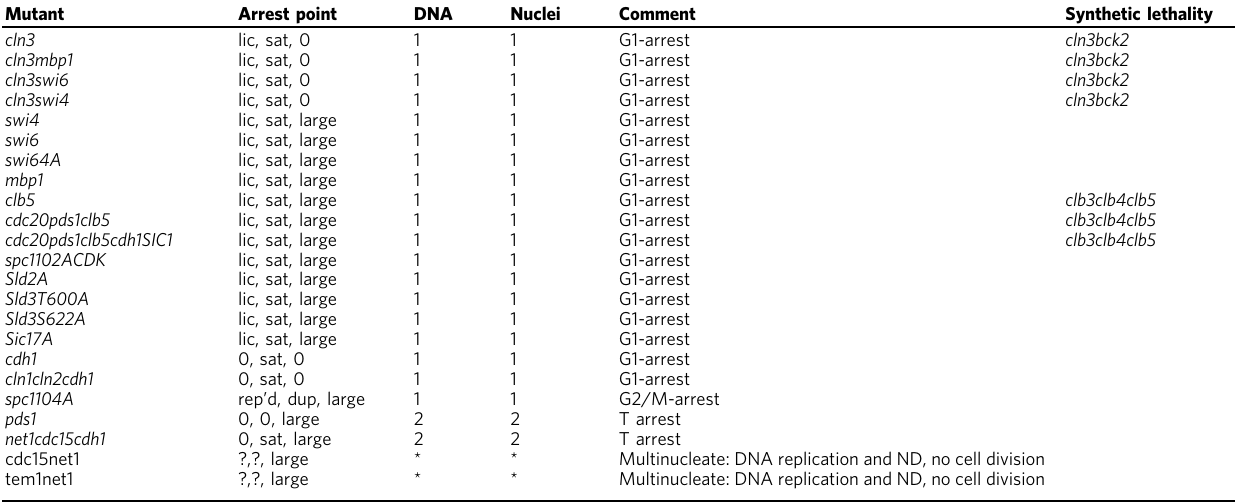
Table 2 List of mutants with phenotypic predictions that are inconsistent with observed phenotypes